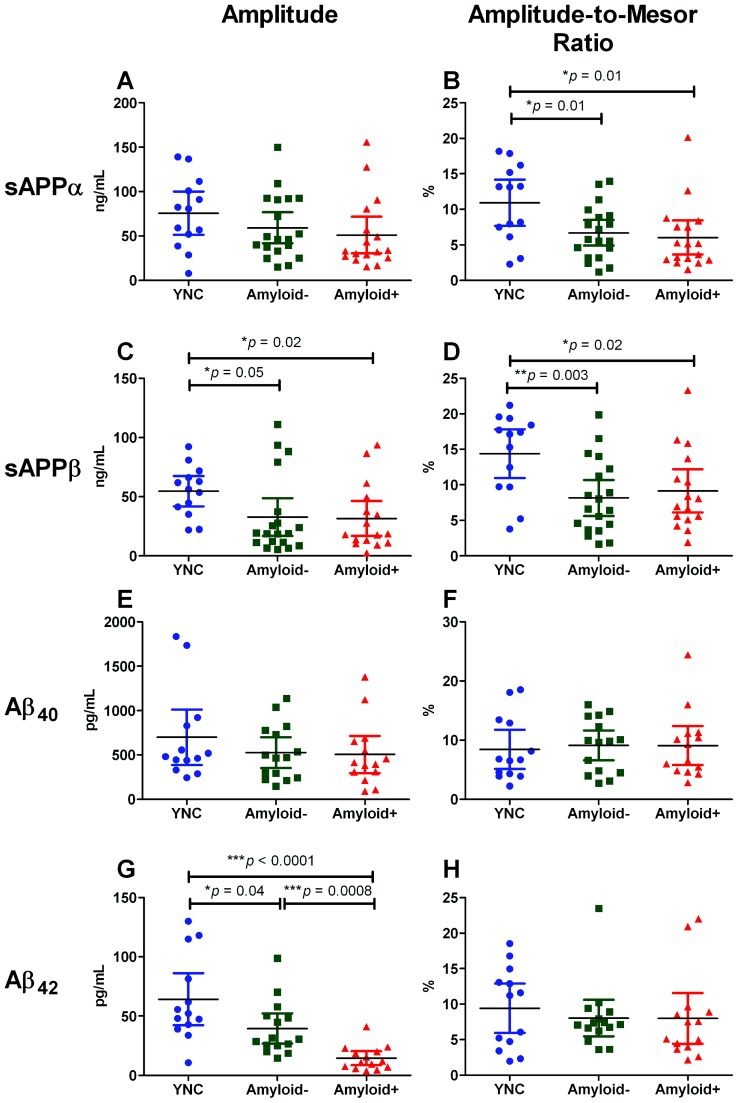
Circadian rhythm parameters of four APP metabolites in YNC, Amyloid−, and Amyloid+ groups.
A) Group-averaged sAPPα amplitudes were not significantly different among groups. B) The sAPPα amplitude-to-mesor ratio was highest in YNC and significantly lower in Amyloid− (*p = 0.01) and Amyloid+ (*p = 0.01). There was no significant difference between the Amyloid− and Amyloid+ groups (p = 0.6). C) Group-averaged sAPPβ amplitudes were significantly higher in YNC than in Amyloid− (*p = 0.05) and Amyloid+ (*p = 0.02). D) The sAPPβ amplitude-to-mesor ratio was highest in YNC and significantly lower in Amyloid− (**p = 0.003) and Amyloid+ (*p = 0.02). There was no significant difference between the Amyloid− and Amyloid+ groups (p = 0.6). E) Group-averaged Aβ40 amplitude values were not significantly different among any of the participant groups. F) Amplitude-to-Mesor ratio for Aβ40 was also not significantly different among groups. G) Group-averaged Aβ42 amplitudes were significantly highest in YNC when compared to Amyloid− (*p = 0.04) and Amyloid+ (***p<0.0001). The Amyloid− group also had a significantly higher Aβ42 amplitude than the Amyloid+ group (***p = 0.0008). H) The Aβ42 amplitude-to-mesor ratios did not differ significantly among groups.